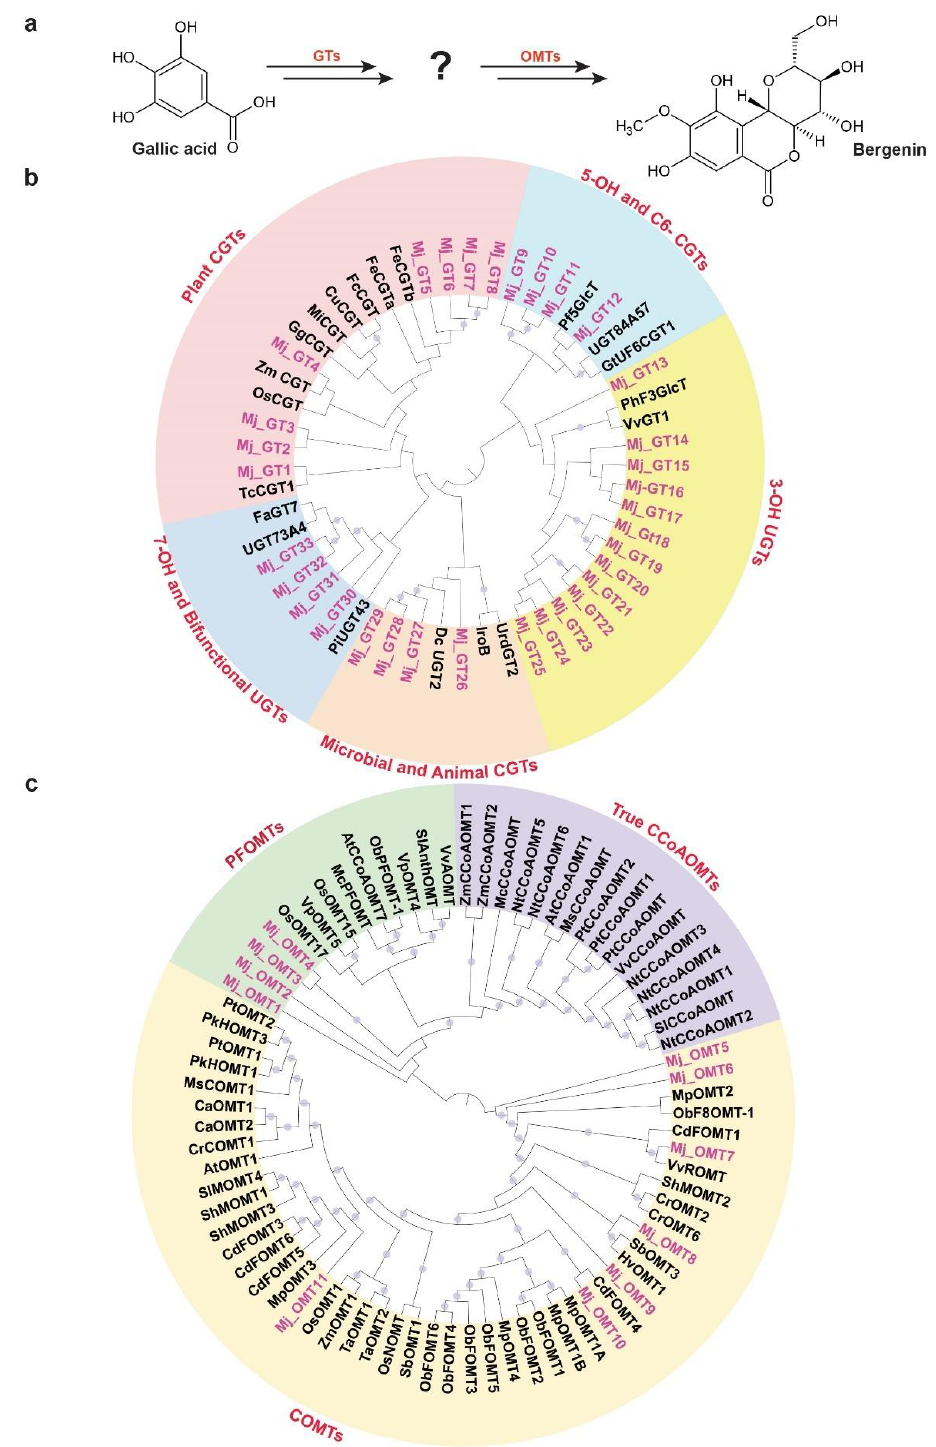
Figure 8. Identification of putative candidate unigenes involved in the biosynthesis of bergenin in Mallotus japonicus . ( a ) Proposed pathway for the conversation of gallic acid to bergenin catalyzed by glucosyltransferases and O -methyltransferases. Phylogenetic analysis of ( b ) glucosyltransferases (GTs) and ( c ) O -methyltransferases (OMTs) using M. japonicus candidate genes together with functionally characterized genes across diverse plant species. Thirty-three and eleven unigenes annotated as GTs and OMTs, respectively, were selected from the transcript modules that were highly correlated with the metabolite module MetM3 and MetM6, which included gallic acid and bergenin, respectively. Nucleotide sequences were translated to their corresponding protein sequences, and the alignment and phylogenetic reconstructions were performed using ETE3 v3.1 after applying 1000 replications. Bootstrap values above 60% are shown